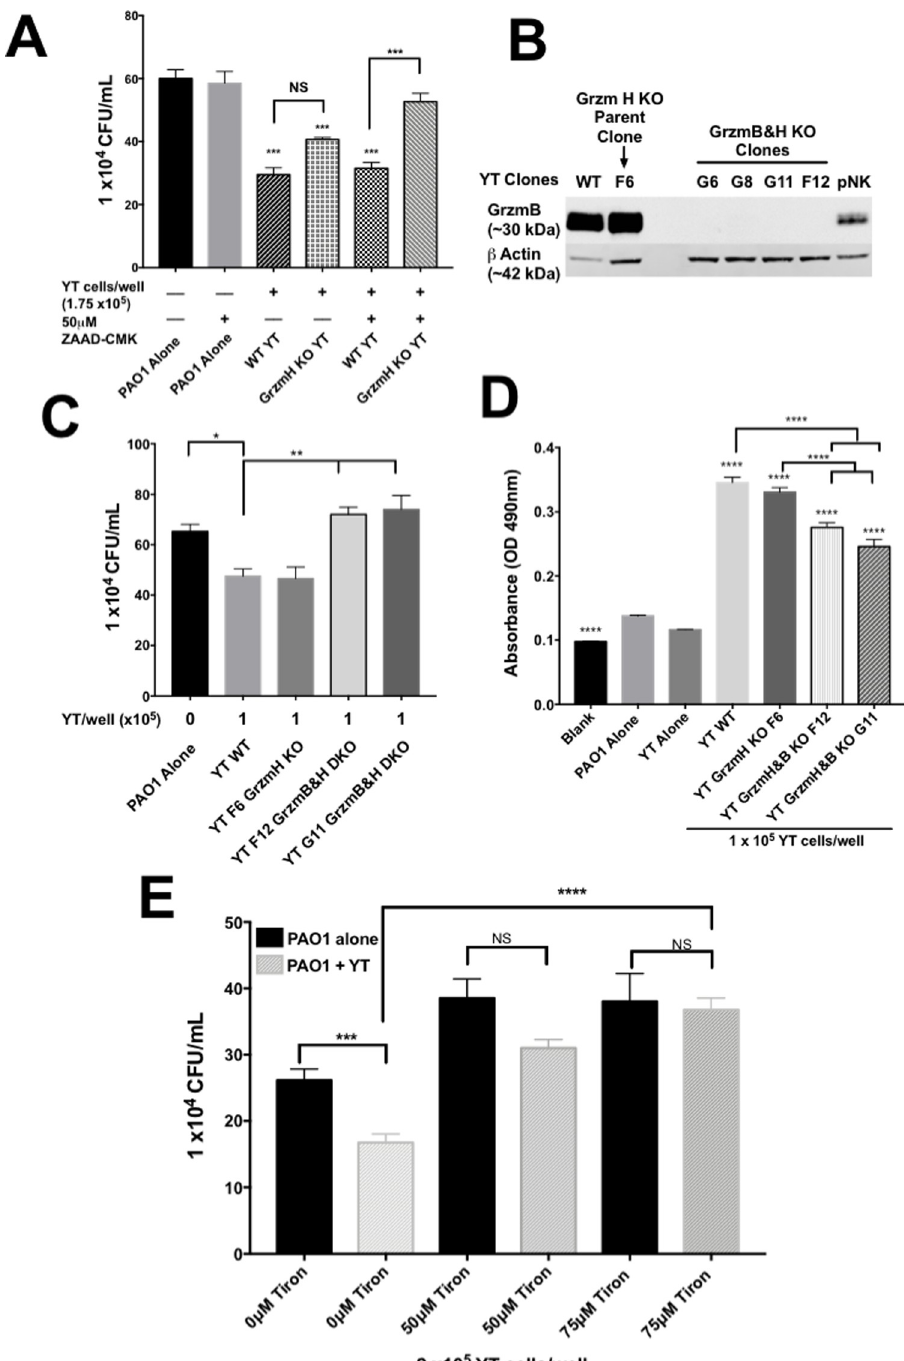
Fig 9. YT cells kill PAO1 using GrzmB&H. (A) PAO1 incubated alone or in the presence of wild type or GrzmH knockout YT cells, treated with 50 μ M ZAAD-CMK or DMSO (vehicle control) and cultured for 6 h, then plated to determine CFU. (B) Western blot analysis of WT, F6 GrzmH KO, GrzmB&H KO YT (5x10 5 cells) and pNK cells (1.4x10 6 cells). Blotted using (1:1000) mouse antibodies specific for human GrzmB (clone: m3304b06) and rabbit antibody specific for human beta actin antibody was used as a loading control. (C) PAO1 incubated alone or in the presence of wild type, GrzmH KO or GrzmB&H knockout YT cell clones YT cells for 6 h then plated to determine CFU. Graph is representative of 2 of the 4 clones tested. All clones demonstrated similar killing ability. (D) PAO1 incubated alone or in the presence of WT, GrzmH KO or GrzmB&H KO YT for 6 h, then diluted 1:10 in sterile